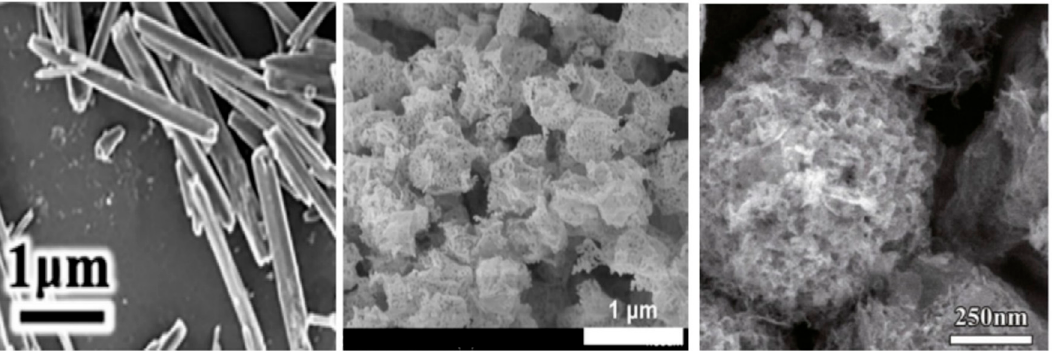
Figure 9. SEM micrographs of some hierarchical photocatalysts obtained with hybrid templates